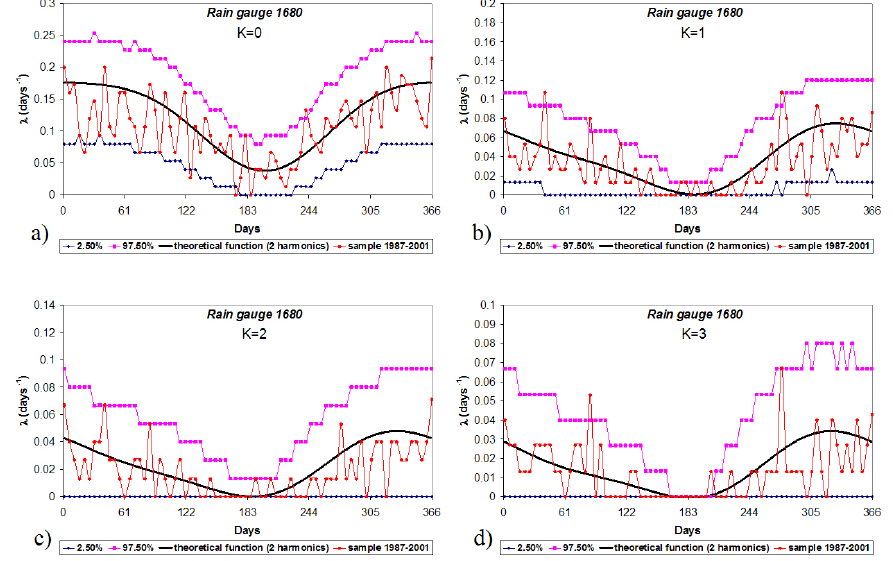
Fig. 9. Crotone rain gauge: confidence interval of sample intensity function λ(t) referred to the validation period for K = 0 (a) , K = 1 (b) , K = 2 (c) and K = 3 (d)